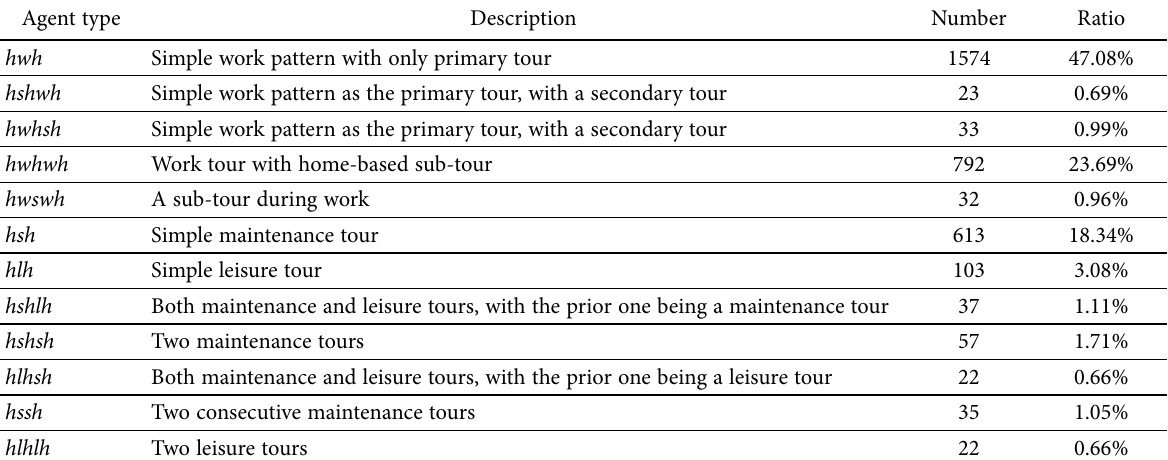
Table 1. Description of generated